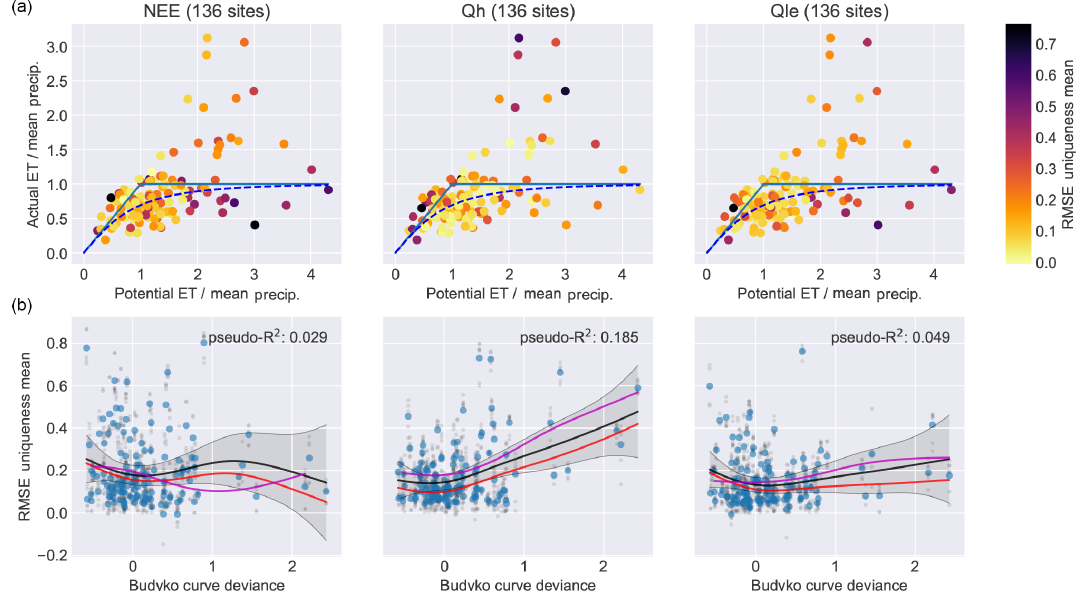
Figure 5. RMSE uniqueness for the Budyko analysis. AET and PET come from the FLUXNET 2015 data, and mean precipitation comes from CRU TS 4.01. In (a) colour indicates RMSE uniqueness averaged across models, in which darker colours are more unique. The solid line represents the theoretical energy and water limitations, and the dotted line represents the Budyko curve (Gerrits et al., 2009). Panel (b) shows sites’ deviance from the Budyko curve normalised by the Budyko expectation for the site (sites>0 lie above the curve in a ).